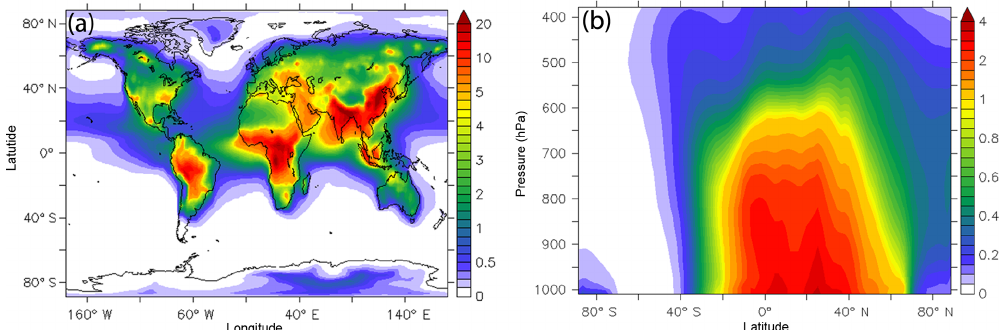
Figure 2. Predicted average (a) surface and (b) zonal concentrations of total OA (in µgm − 3 ) during the years 2001–2010.